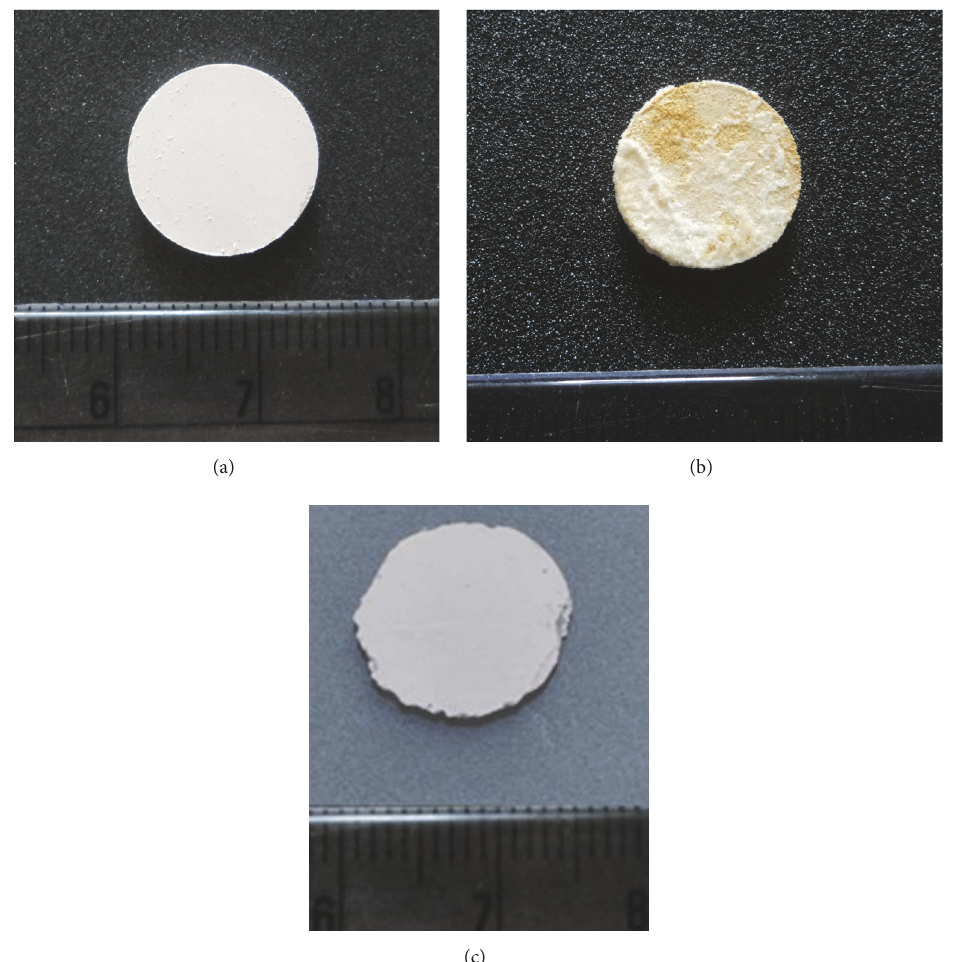
Figure 2: Macroscopic view of SrTiO 3 surface, (a) before exposure to hot corrosion and after exposure to (b) Na 2 SO 4 + 50 wt.% V 2 O 5 environment and (c) Na 2 SO 4 + 10 wt.% NaCl environment at 900 ∘ C.